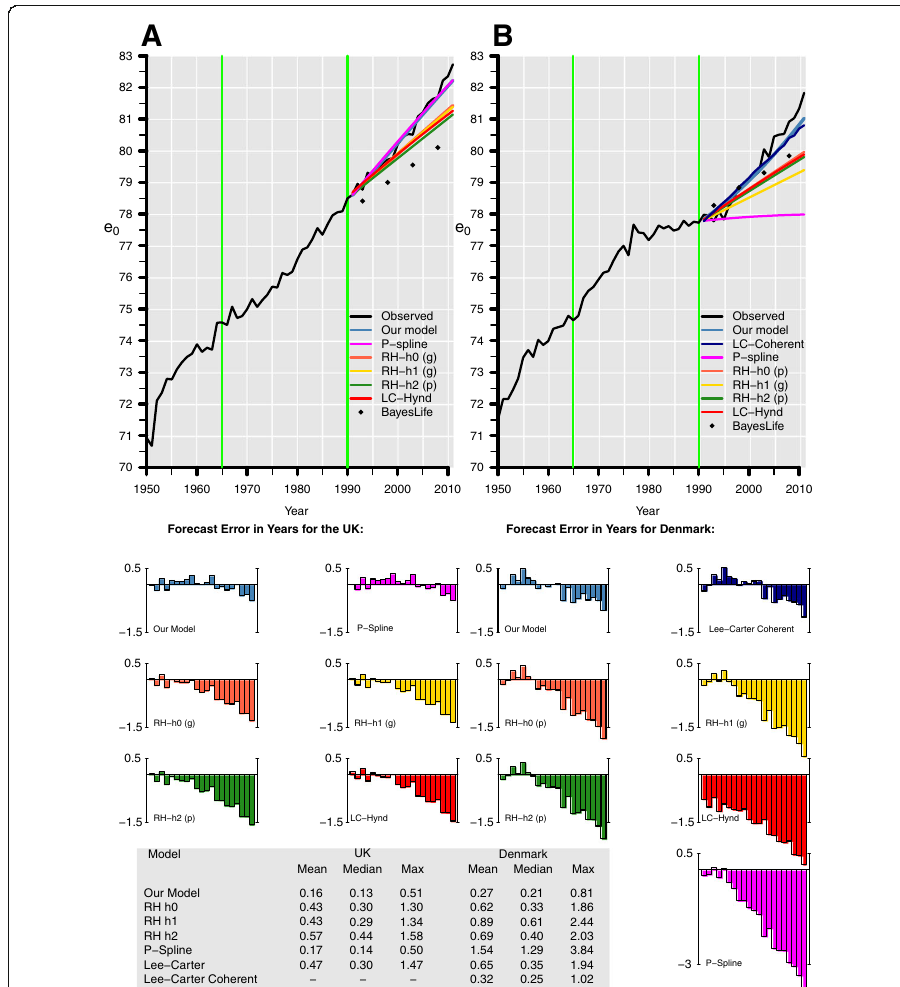
Fig. 3 Observed ( black line ) and forecasted life expectancy at birth ( e 0 ) of our model ( blue ), the P-spline approach ( magenta ), the LC model ( red ), four of its variants — h0 ( light red ), h1 ( yellow ), h2 ( green ), and coherent ( navy blue — and of the UN Bayesian approach ( squares ) for women in the UK ( left ) and Denmark ( right ). The validating forecasts from 1991 to 2011 rely on data from 1965 to 1990 ( green vertical lines ). We combine the mortality trends of Danish and Swedish women in our model as well as in the coherent LC forecast. In the RH models, (p) and (g) denote Poisson and Gaussian errors, respectively. Forecast errors are shown for all